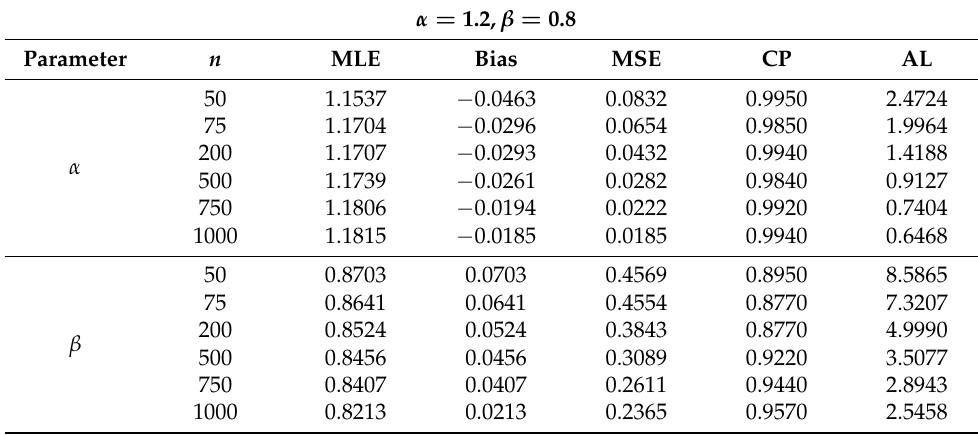
Table 4. Simulation results for α = 1.2 and β =